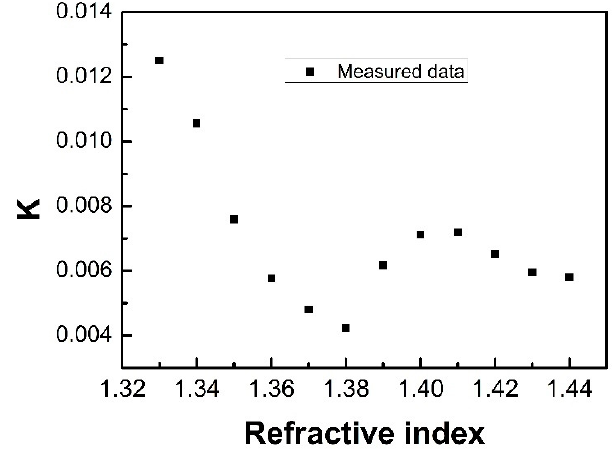
Figure 9. RI sensing performances for the sensor probe with a bending structure, where the active fiber diameter was 100 μ m, passive fiber diameter was 200 μ m, twisted region length was 12 mm, and the macrobending radius was 3 mm.